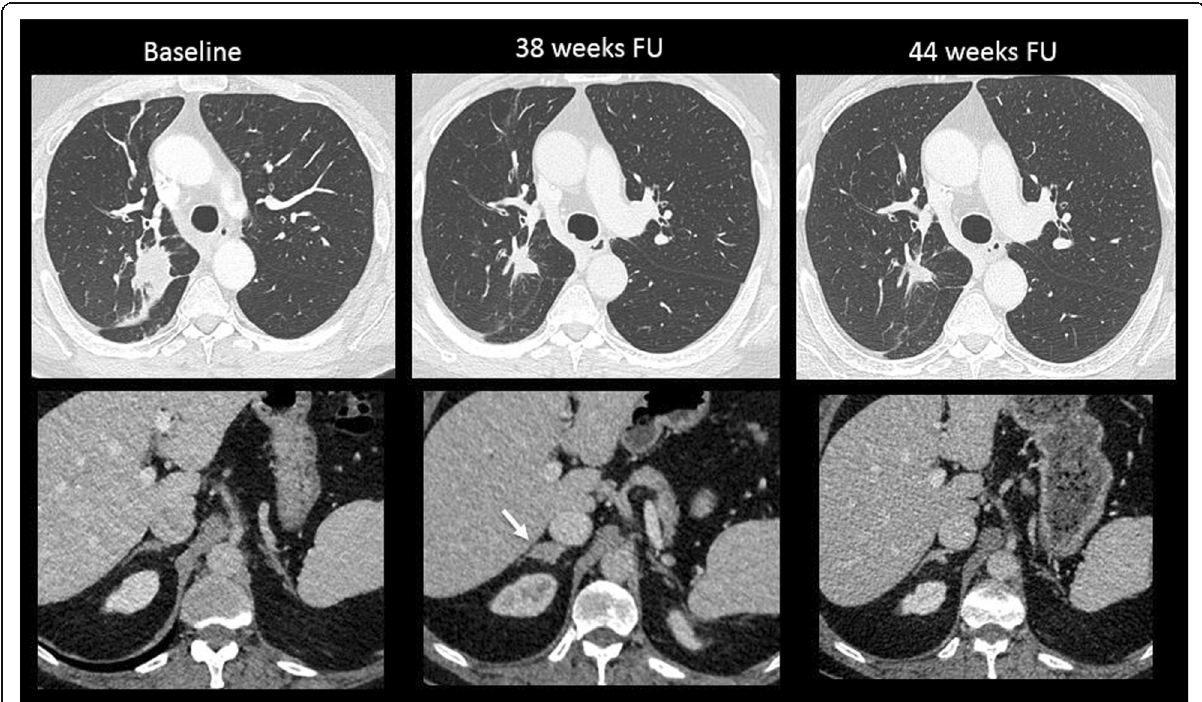
Fig. 3 Pseudoprogression in a 65-year-old patient with lung carcinoma treated with nivolumab (anti-PD-1). Baseline axial CT showed a lung mass in the upper right lobe with normal adrenal glands. At a 38-week follow-up (FU), there was a good reduction in the size of the lung mass, but a new lesion appeared in the right adrenal gland (arrow). The patient was maintained under the same treatment. At 44-week follow-up, the right adrenal mass disappeared, confirming the diagnosis of